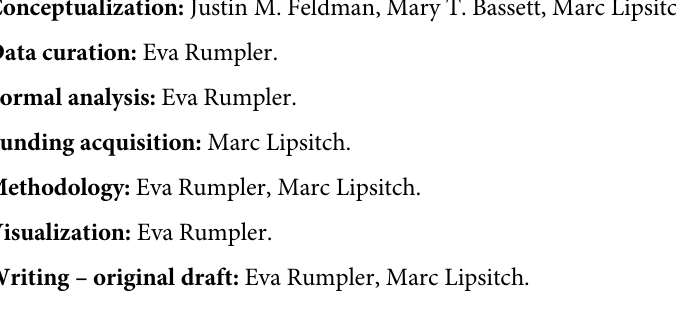
S5 Table. Relative number of lives saved comparing a policy allocating vaccines to 65–74 year olds (policy S) to one allocating vaccines to front-line workers (policy F). Results shown for varying values of R , the increased risk of infection for front-line workers. The ratios for an R value of 1 � 56 correspond to those shown in Table 3. "NH" stands for "Non-Hispanic", "2+ races" stands for "Two or more races", "Native" stands for "American Indian or Alaska Native", "NHPI" stands for "Native Hawaiian or Other Pacific Islander". S6 Table. Number of years of life saved by vaccinating 1,000 individuals, either allocating doses to 65–74 year olds (policy S), or to front line workers (policy F). The ratio YS j the relative number of lives saved comparing the two policies. Results shown for each US state per race/ethnicity categories. "NH" stands for "Non-Hispanic", "2+ races" stands for "Two or more races", "Native" stands for "American Indian or Alaska Native", "NHPI" stands for "Native Hawaiian or Other Pacific Islander". S7 Table. Relative number of years of life saved comparing a policy allocating vaccines to 65–74 year olds (policy S) to one allocating vaccines to front-line workers (policy F). Results shown for varying values of R , the increased risk of infection for front-line workers. The ratios for an R value of 1 � 56 correspond to those shown in Table 4. "NH" stands for "Non- Hispanic", "2+ races" stands for "Two or more races", "Native" stands for "American Indian or Alaska Native", "NHPI" stands for "Native Hawaiian or Other Pacific